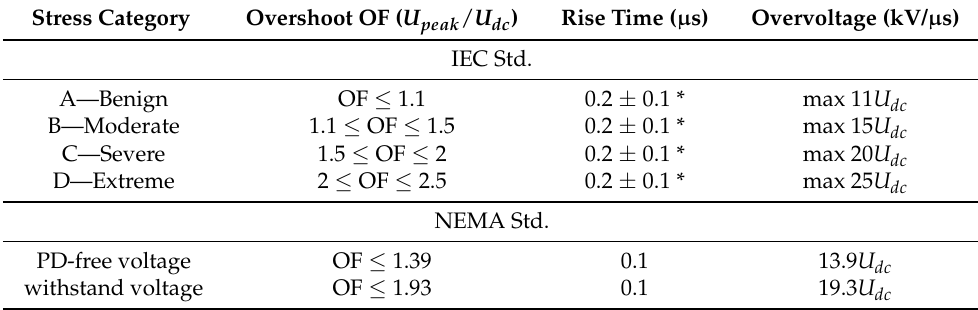
Table 2. Comparison of the overvoltages: IEC (Type I) and NEMA standard. Stress